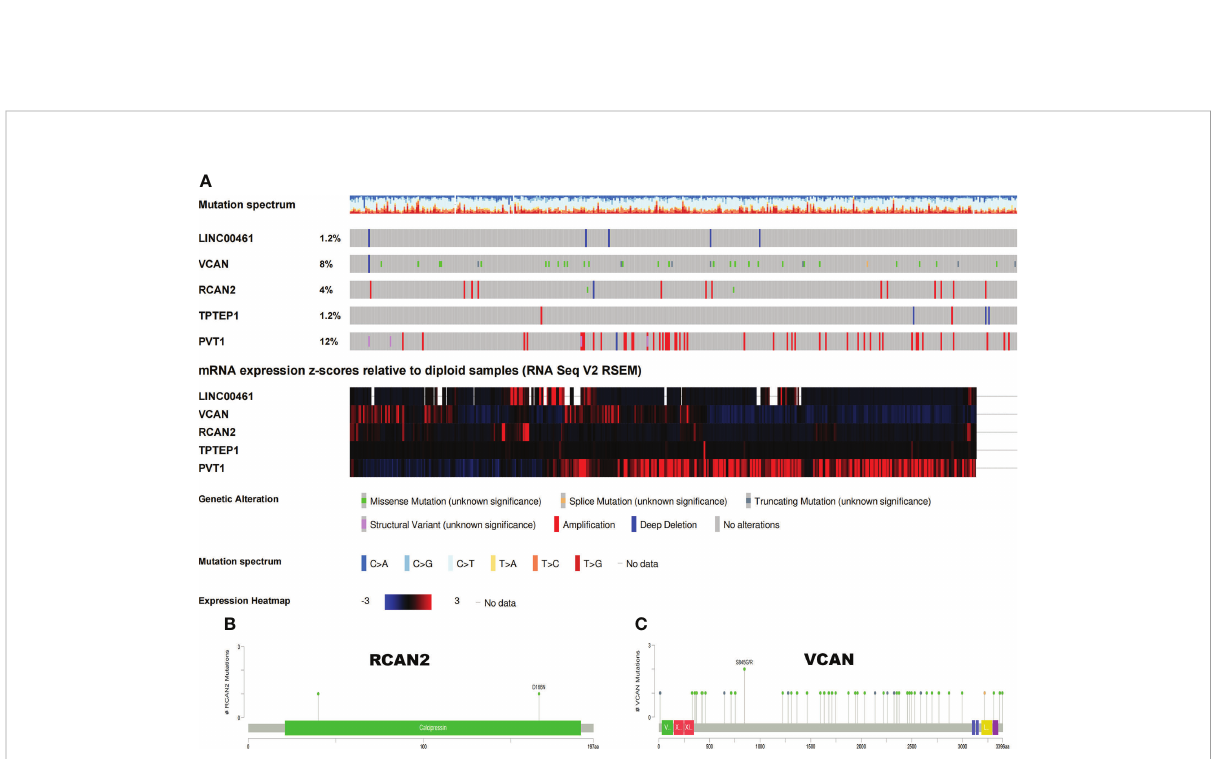
FIGURE 7 Somatic mutation map of 5 ceRNAs. (A) Mutation frequency and expression of 5 ceRNAs. (B, C) Mutation patterns of VCAN and RCAN2.